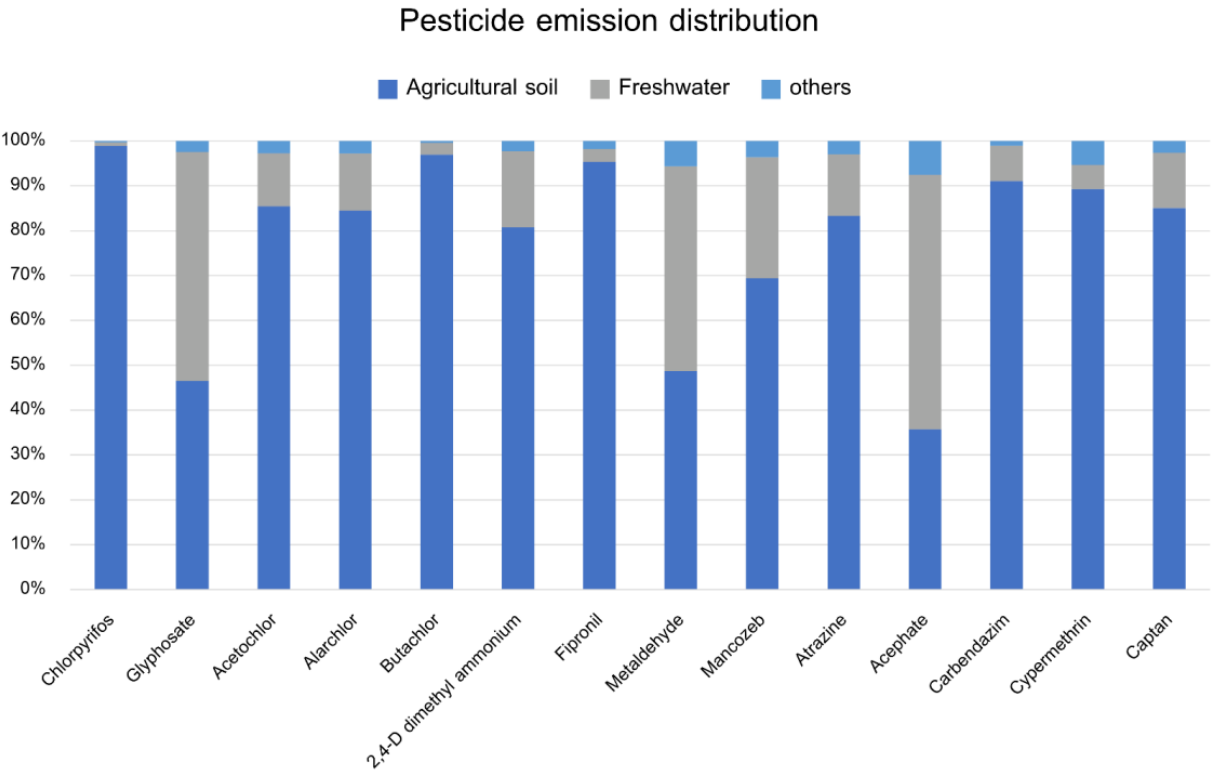
Figure 5. Pesticide emission